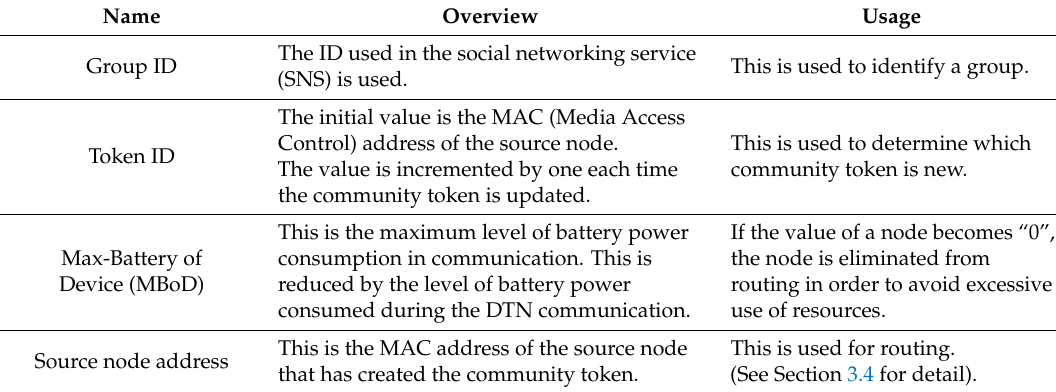
Table 3. Contents of a community